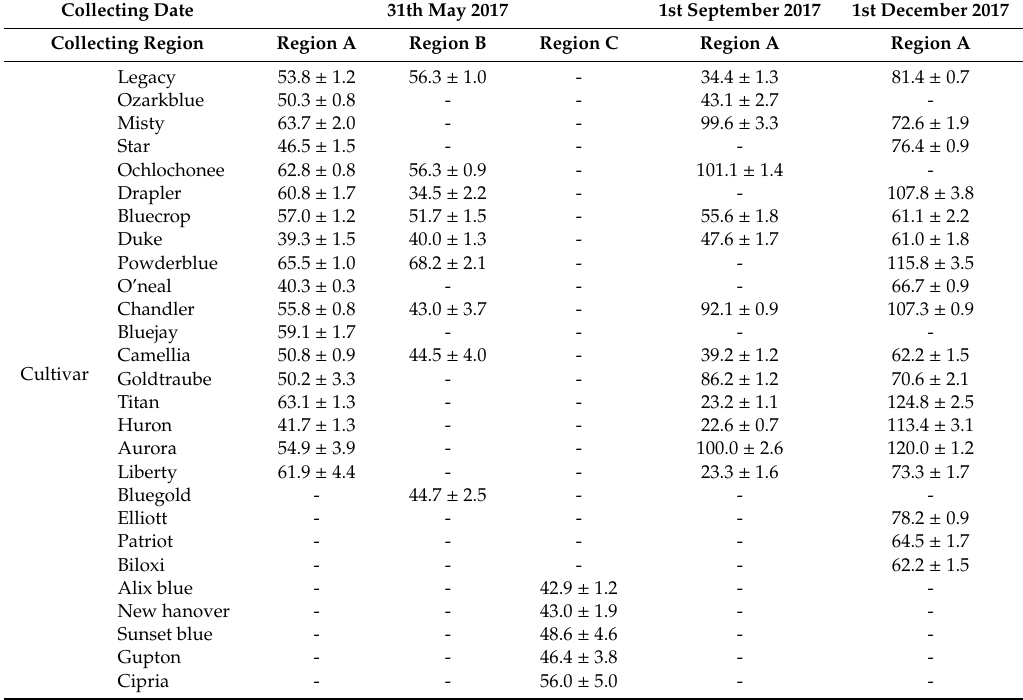
Table 3. Total antioxidant capacity (TAC), expressed in mM of Trolox / g dry leaf, obtained for all the cultivar leaves extracts harvested in the three geographic regions and three seasons across the vegetative